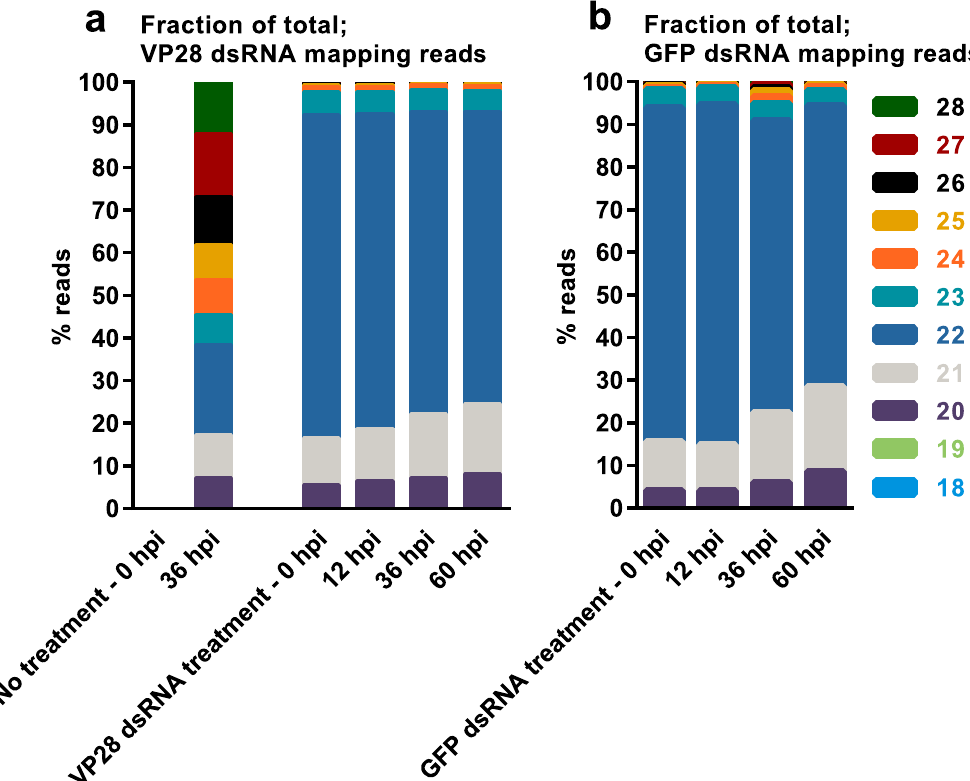
Figure 9. Small RNA length distribution given as fractions of total. RNA was isolated from stomach tissue and equal amounts were pooled for each sample within a given group at a given time point. RNA sequencing was performed on these pools and obtained data was subjected to an analysis of read length distribution frequency. Here, relative distribution of read lengths obtained from reads mapping to the VP28 ( a ) and GFP ( b ) dsRNA treatment sequence are shown to emphasize the dominance of 22 nt reads in samples were the only source of such sequences are the injected